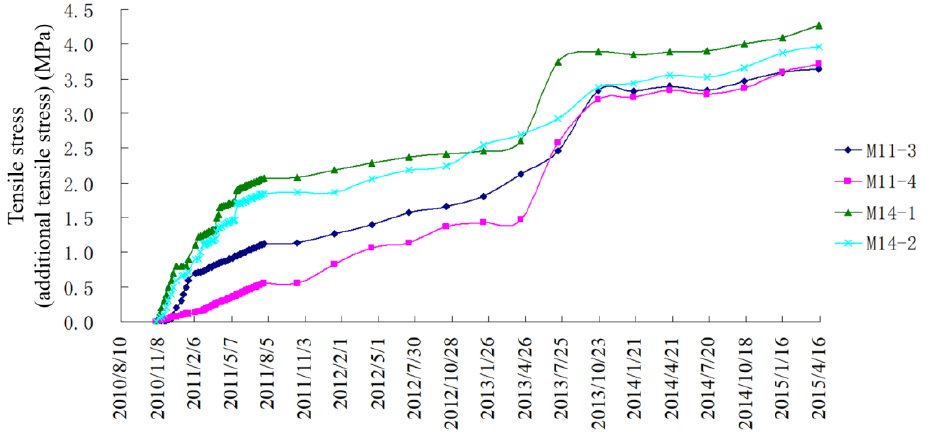
Figure 14. The stress–time curve of each measuring point of fault F2 monitored by the bolt stress meter.